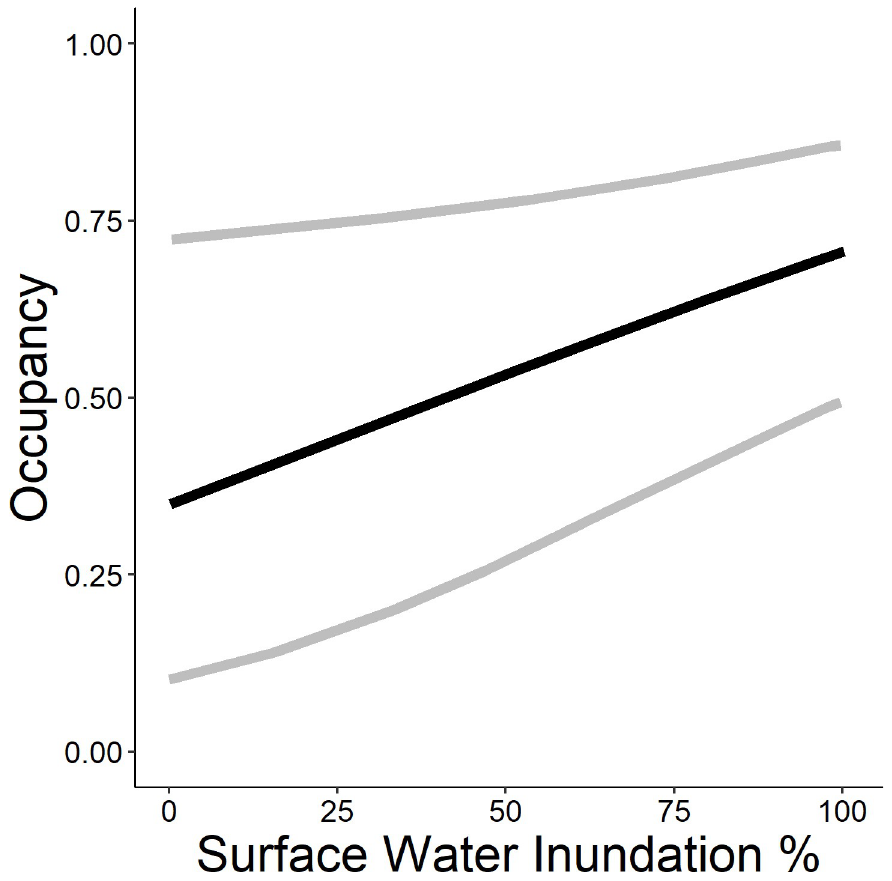
Fig 7. Predicted probability (95% confidence limits) of site occupancy for the emergent marsh bird group (American bittern, Botaurus lentiginosus ; least bittern, Ixobrychus exilis ; sora, Porzana Carolina ; king rail, Rallus elegans ; virginia rail Rallus limicola , and yellow rail, Coturnicops noveboracensis ) across percent surface water inundation in Illinois during late spring and early summer 2015–2017.